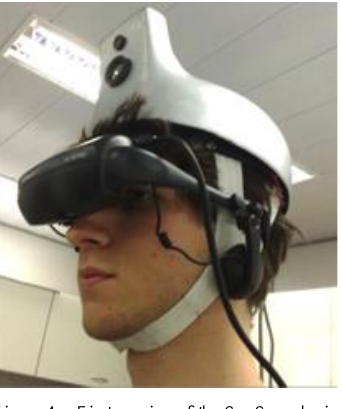
Figure 4. First version of the CapCam